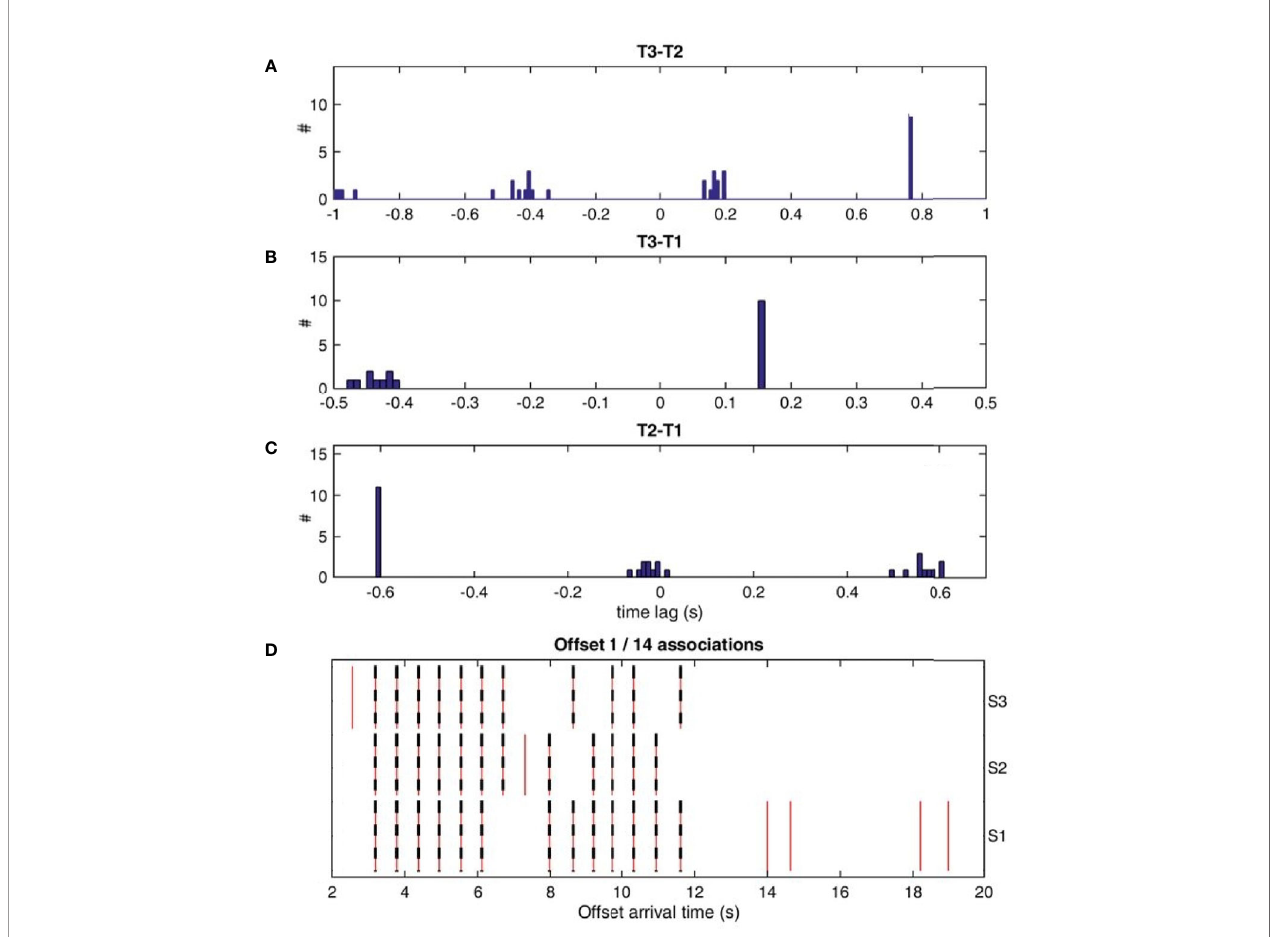
FIGURE 9 | Cross-correlation histograms between the arrival patterns of Figure 7D for the three different hydrophone combinations: (A) SWAN3-SWAN2, (B) SWAN3-SWAN1 and (C) SWAN2-SWAN1; the vertical axes (#) in panels (A – C) measure histogram counts.. (D) Aligned arrival patterns (red) using the opposites of the offsets in panels (B, C) . Arrival associations (14 in total) are marked by the black dashed lines; 8 of them correspond to arrival associations among all three hydrophones (enabling 3H localizations) while the rest 6 correspond to arrival associations between various pairs of hydrophones (enabling 2H